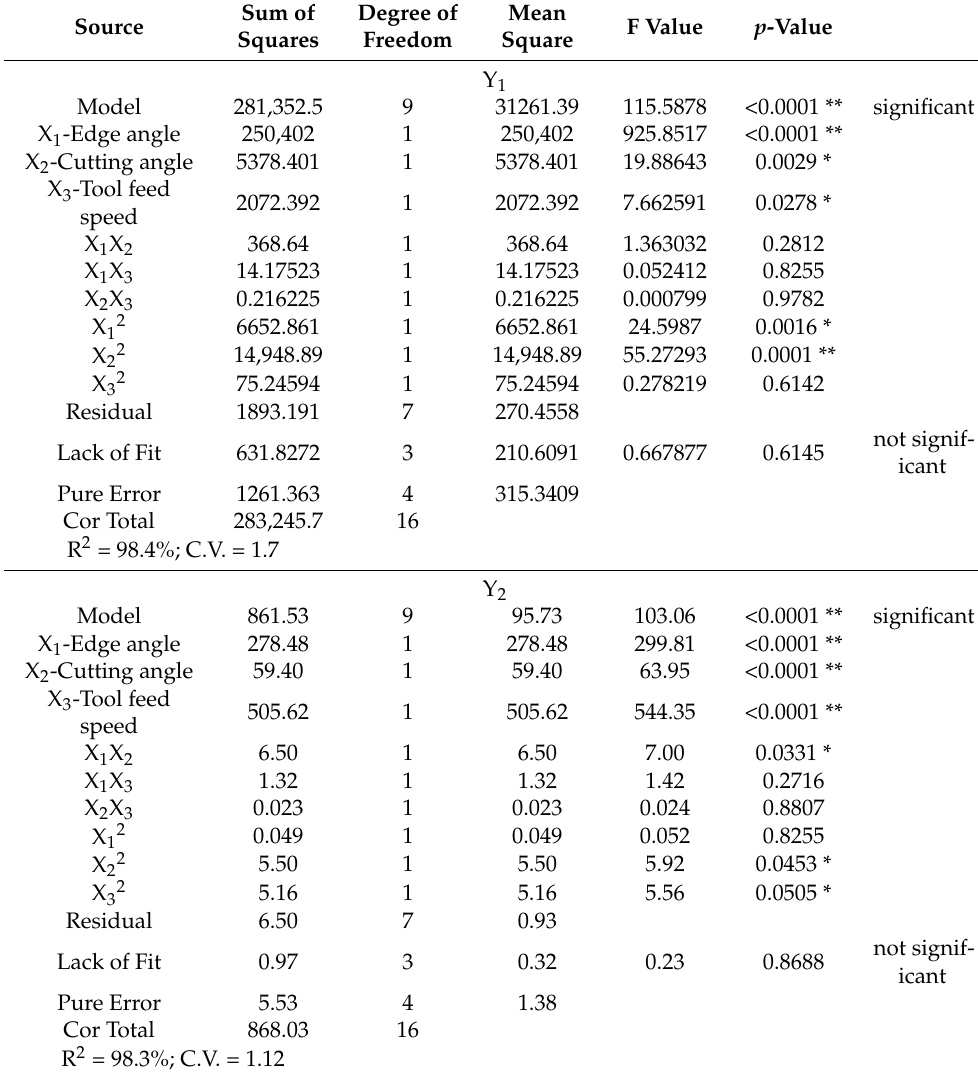
Table 6. ANOVA results for the fitted regression models of Y 1 and Y 2